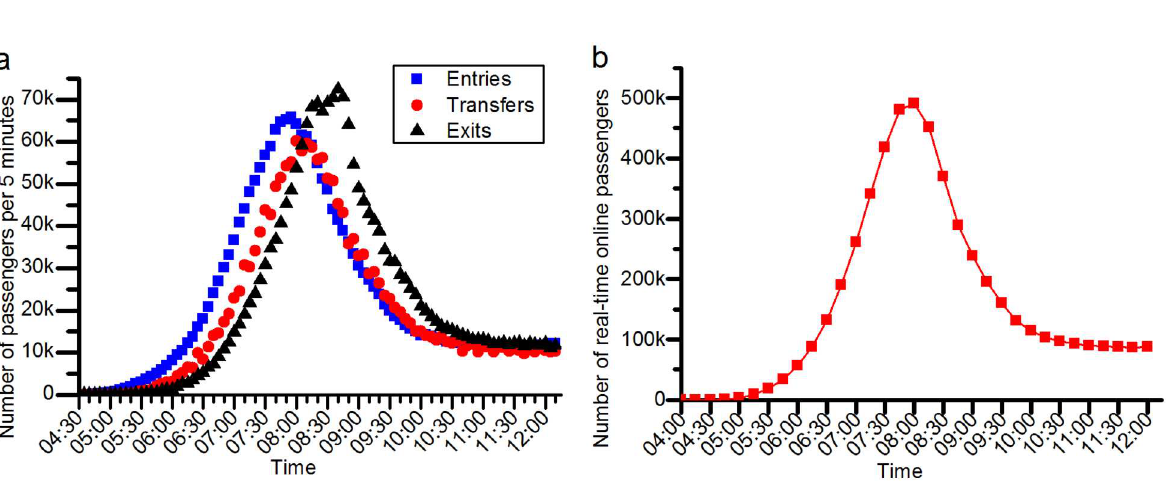
tions after JISHUITAN station is closed. We can see that GULOUDAJIE station to the east of